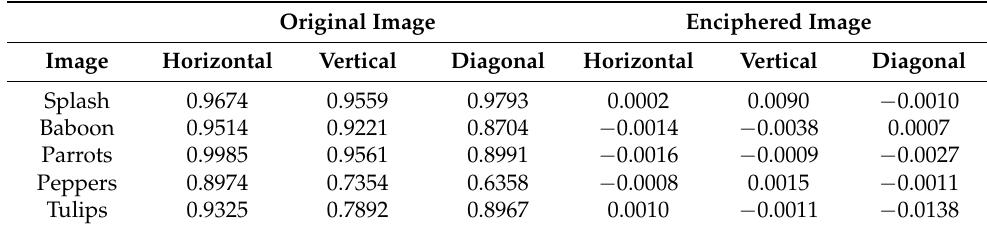
Table 2. Correlation Coefficient results for different